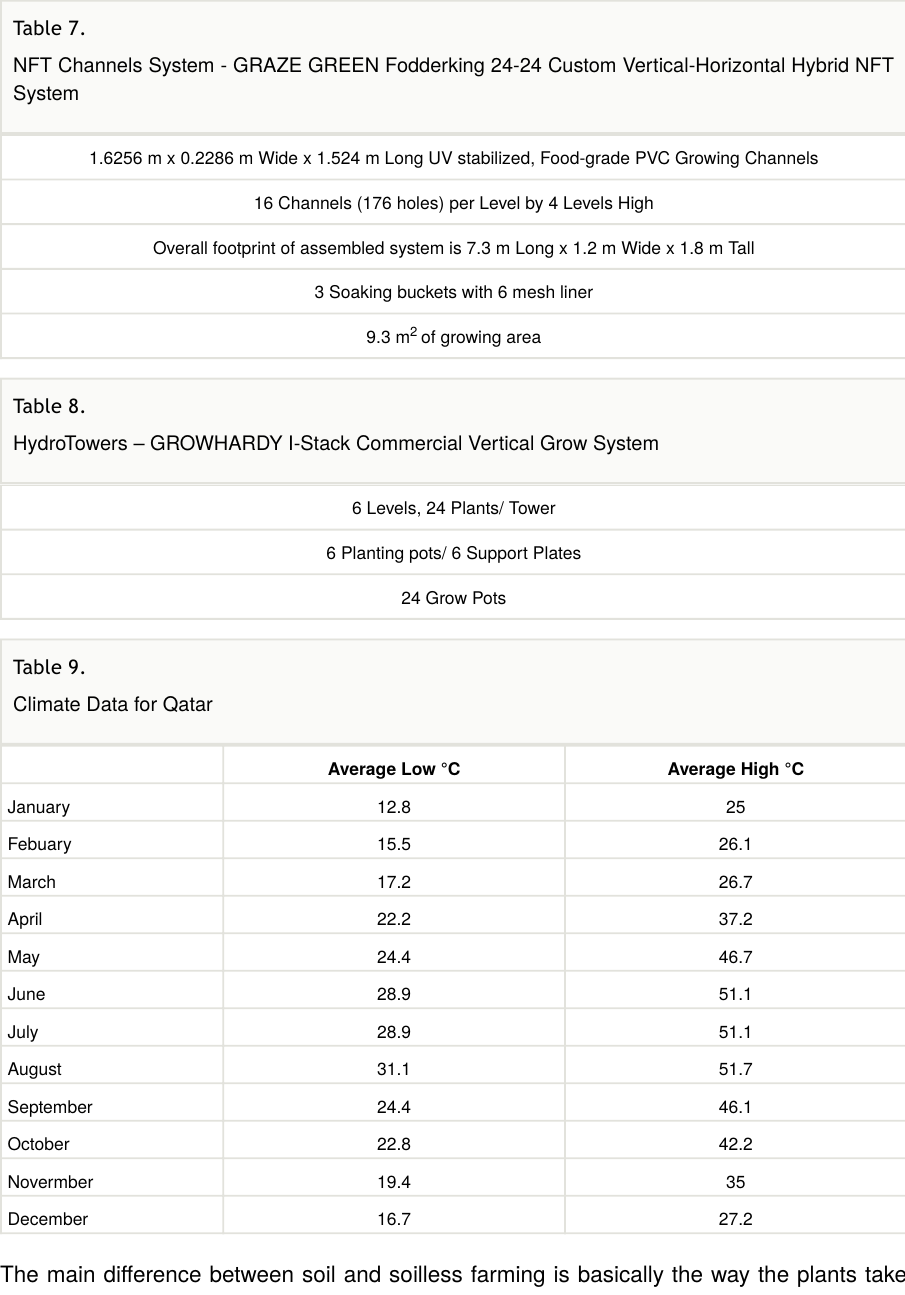
Climate Data for